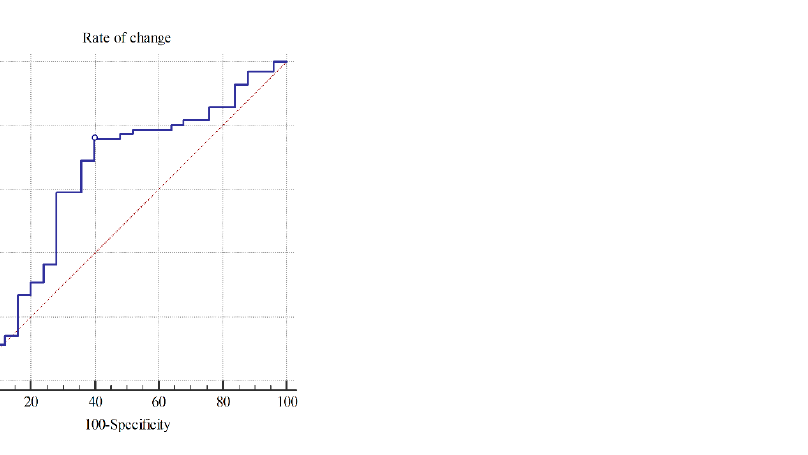
Table 3. Multivariable logistic regression analysis for poor neurologic outcome with baseline variables and rate of optic nerve sheath diameter change.